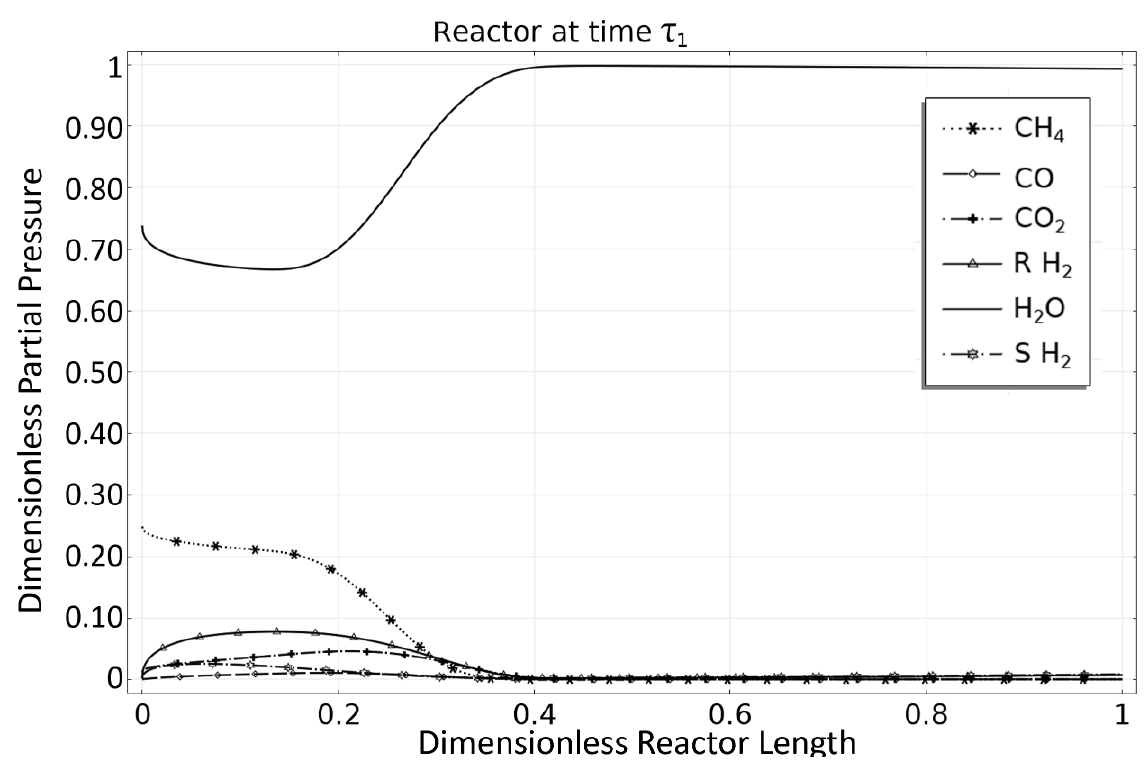
Figure 7. Species’ dimensionless partial pressure axial length profile during cycle 3 at the end of OM 1 for Da = 2, Θ = 10.